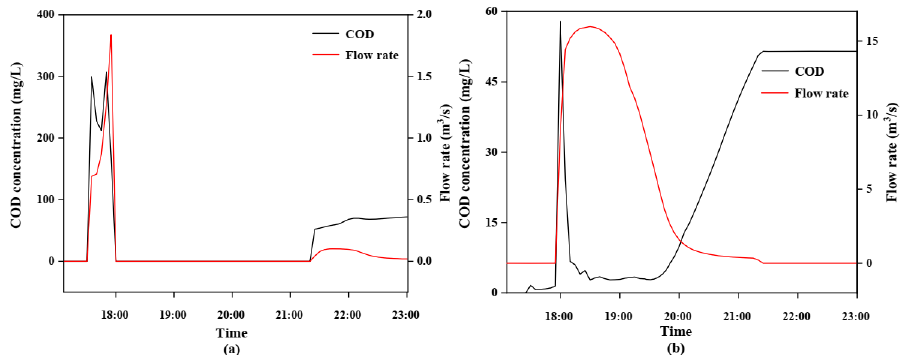
Figure 12. The simulation of double-gate scheme based on water quality: ( a ) COD interception of double-gate scheme based on water quality; ( b ) COD concentration of overflow of double-gate scheme based on water